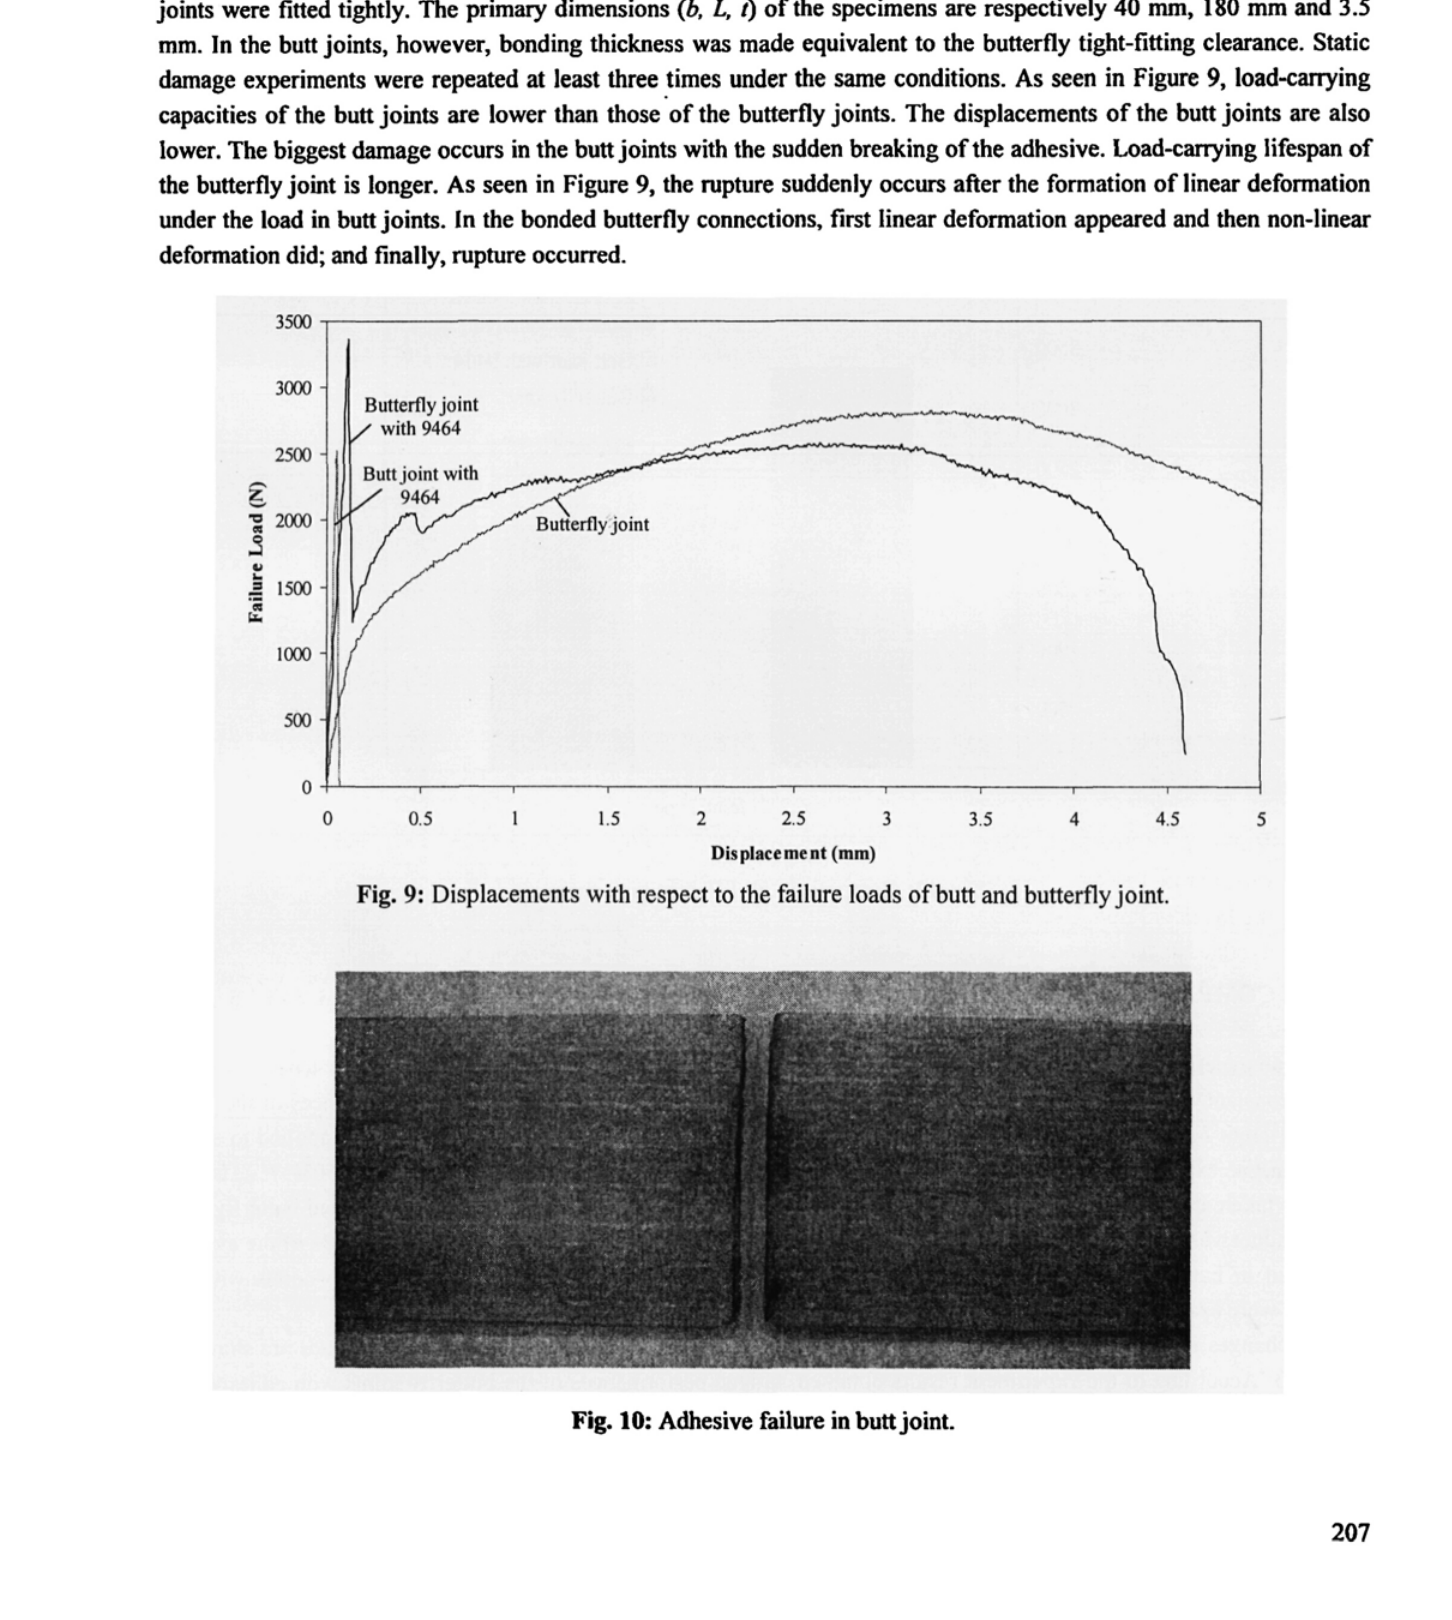
Fig. 10: Adhesive failure in butt